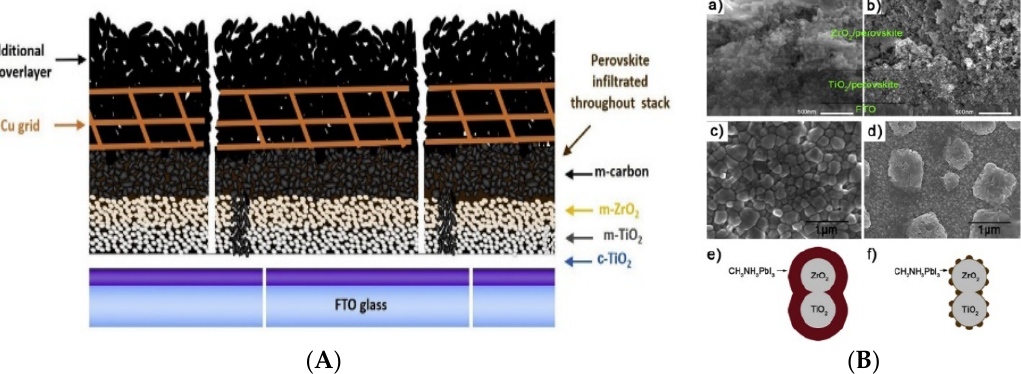
Figure 2. ( A ) Stack configuration with Cu metal grids; ( B ) SEM top view and cross section of FTO/TiO 2 /ZrO 2 /PVK/Carbon and illustration about perovskite poor filling issue. Figure 2A,B is reprinted with permission from references [70,72], respectively.